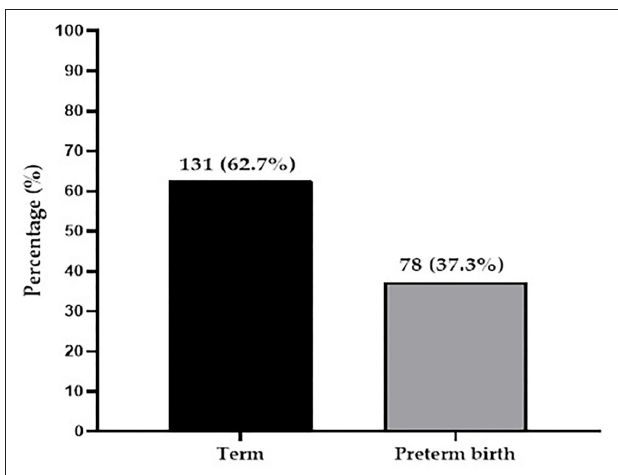
FIGURE 1 | Prevalence of preterm birth among study participants.